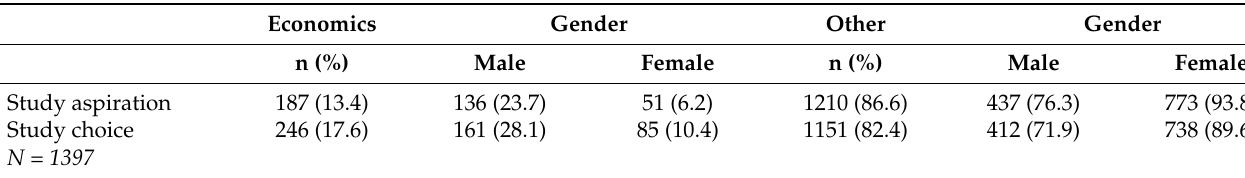
Table 7. Gender and study choices.